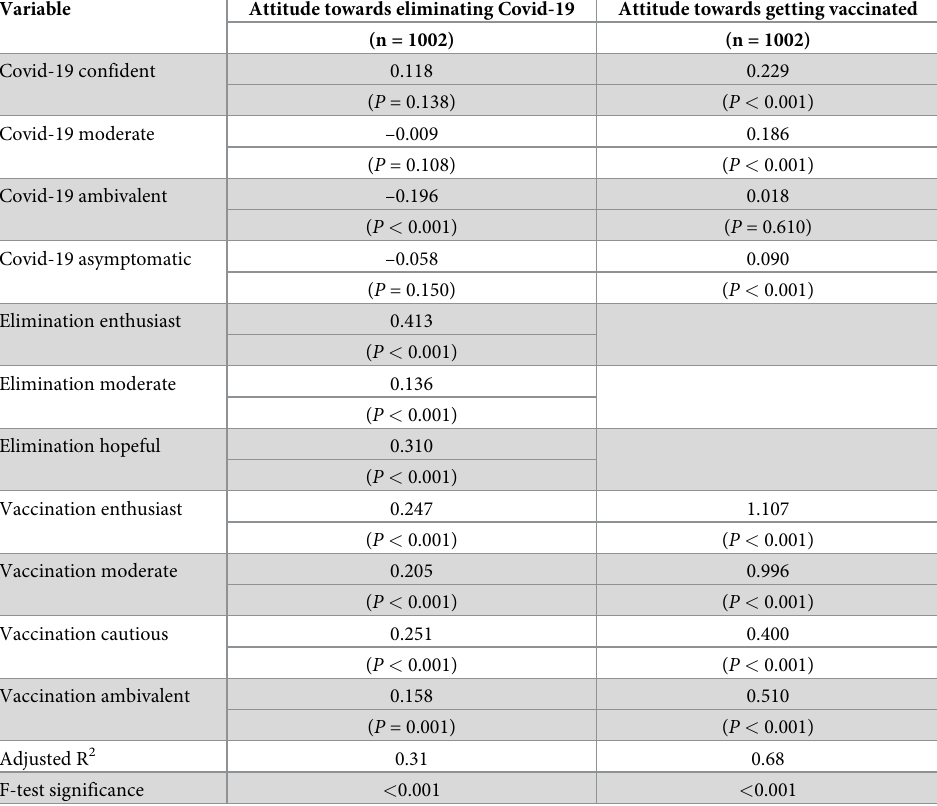
Table 9. Estimates of standardised parameters for attitudes towards eliminating Covid-19 and Covid-19 vaccination.